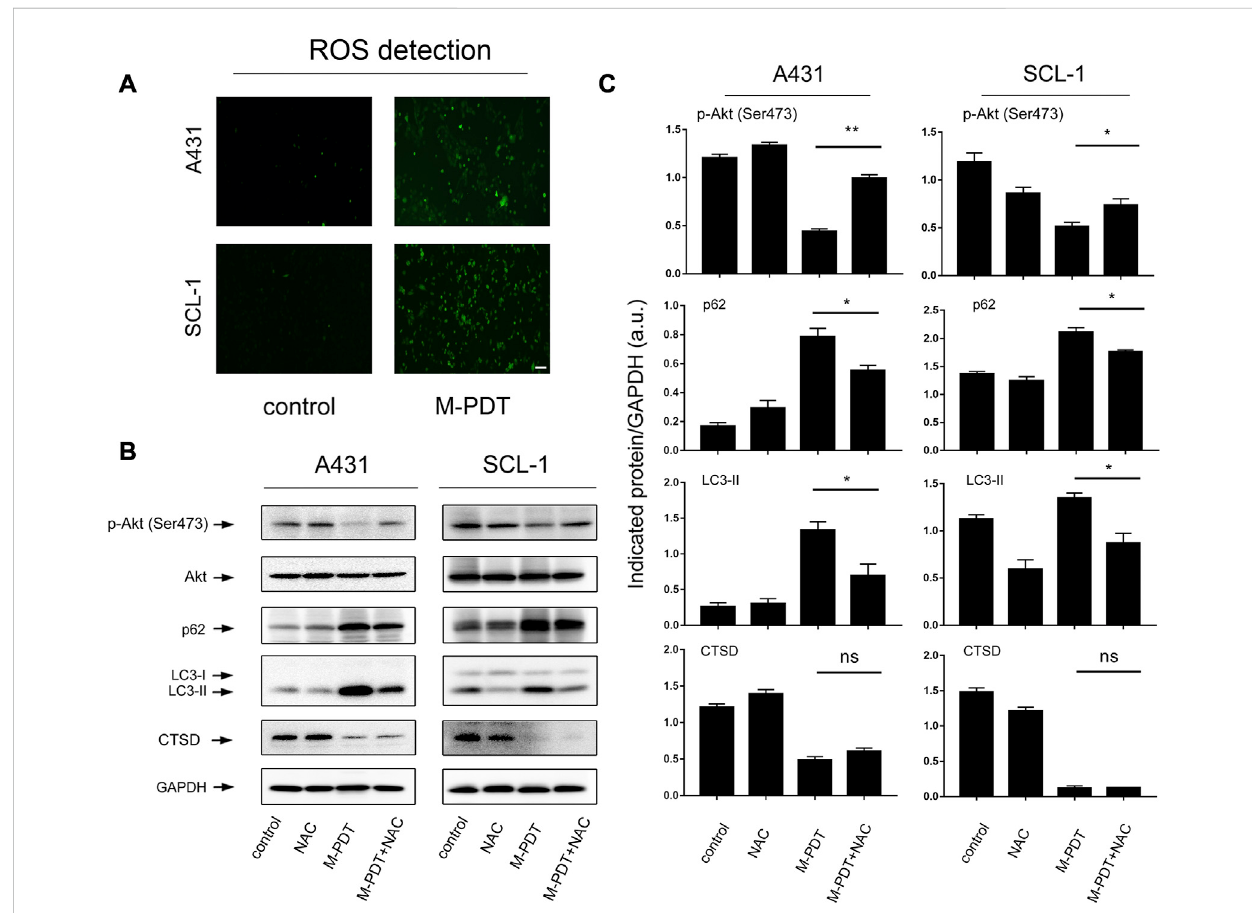
FIGURE 6 M-PDTimpairsautophagic fl uxthroughROS-mediatedinhibitionofAkt/mTORpathwayincSCCcells. (A) ROSproductionwasmeasuredbyDCFH- DAprobe,thescalebaris100 μ m. (B) TotalcelllysatesweresubjectedtoWesternblottingusingindicatedantibodies.GAPDHisaloadingcontrol. (C) The blots for p-Akt, LC3-II, p62, and CTSD were semi-quanti fi ed. * p < 0.05, ** p < 0.01. n =